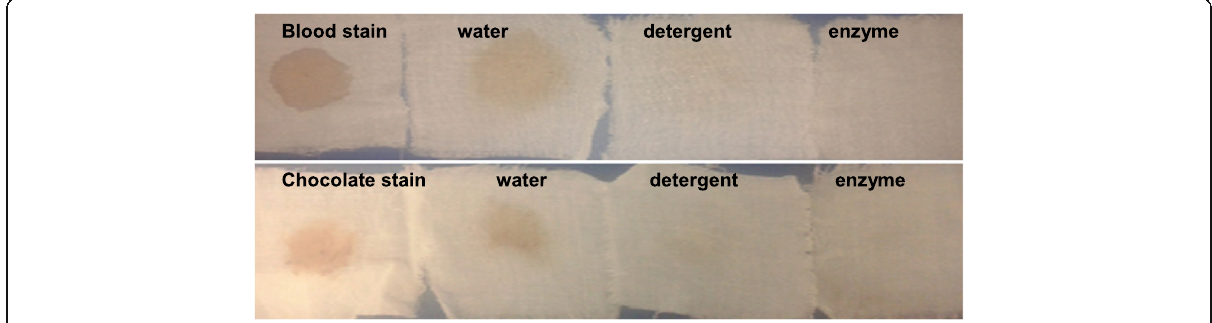
Fig. 4 Washing performance test for crude protease/keratinase YNDH in contrast to detergent and water. Stained cloth pieces with blood or chocolate in the left (control: untreated stained cloth pieces). Stained cloth pieces washed with distilled water, Det. (7 mg/ml), and crude enzyme equivalent (20